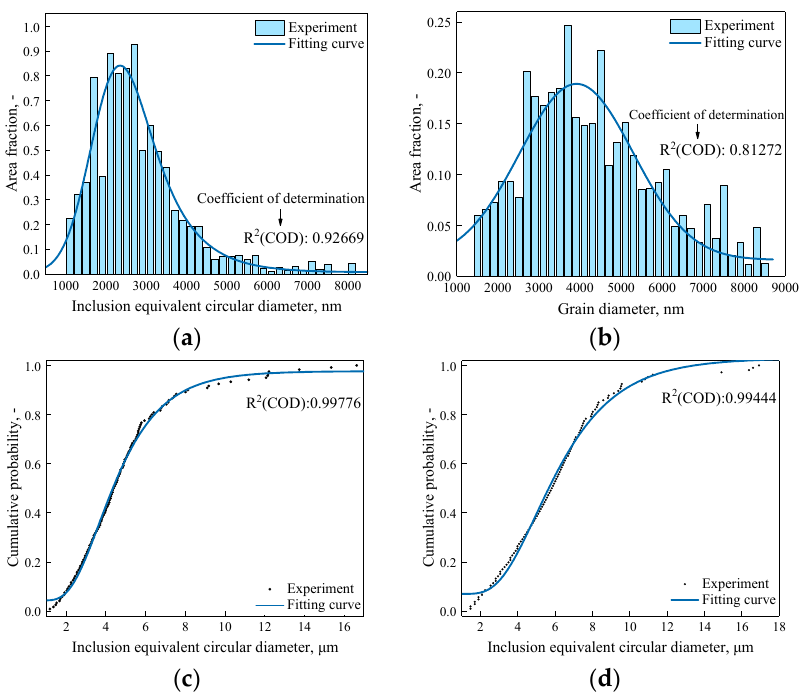
Figure 11. Logarithmic normal distribution and cumulative distribution function of sulfide inclusions and oxide inclusions ( a ) Logarithmic normal distribution of sulfide inclusions; ( b ) Logarithmic normal distribution of oxide inclusions; ( c ) Cumulative distribution function of sulfide inclusions; ( d ) Cumulative distribution function of oxide inclusions.